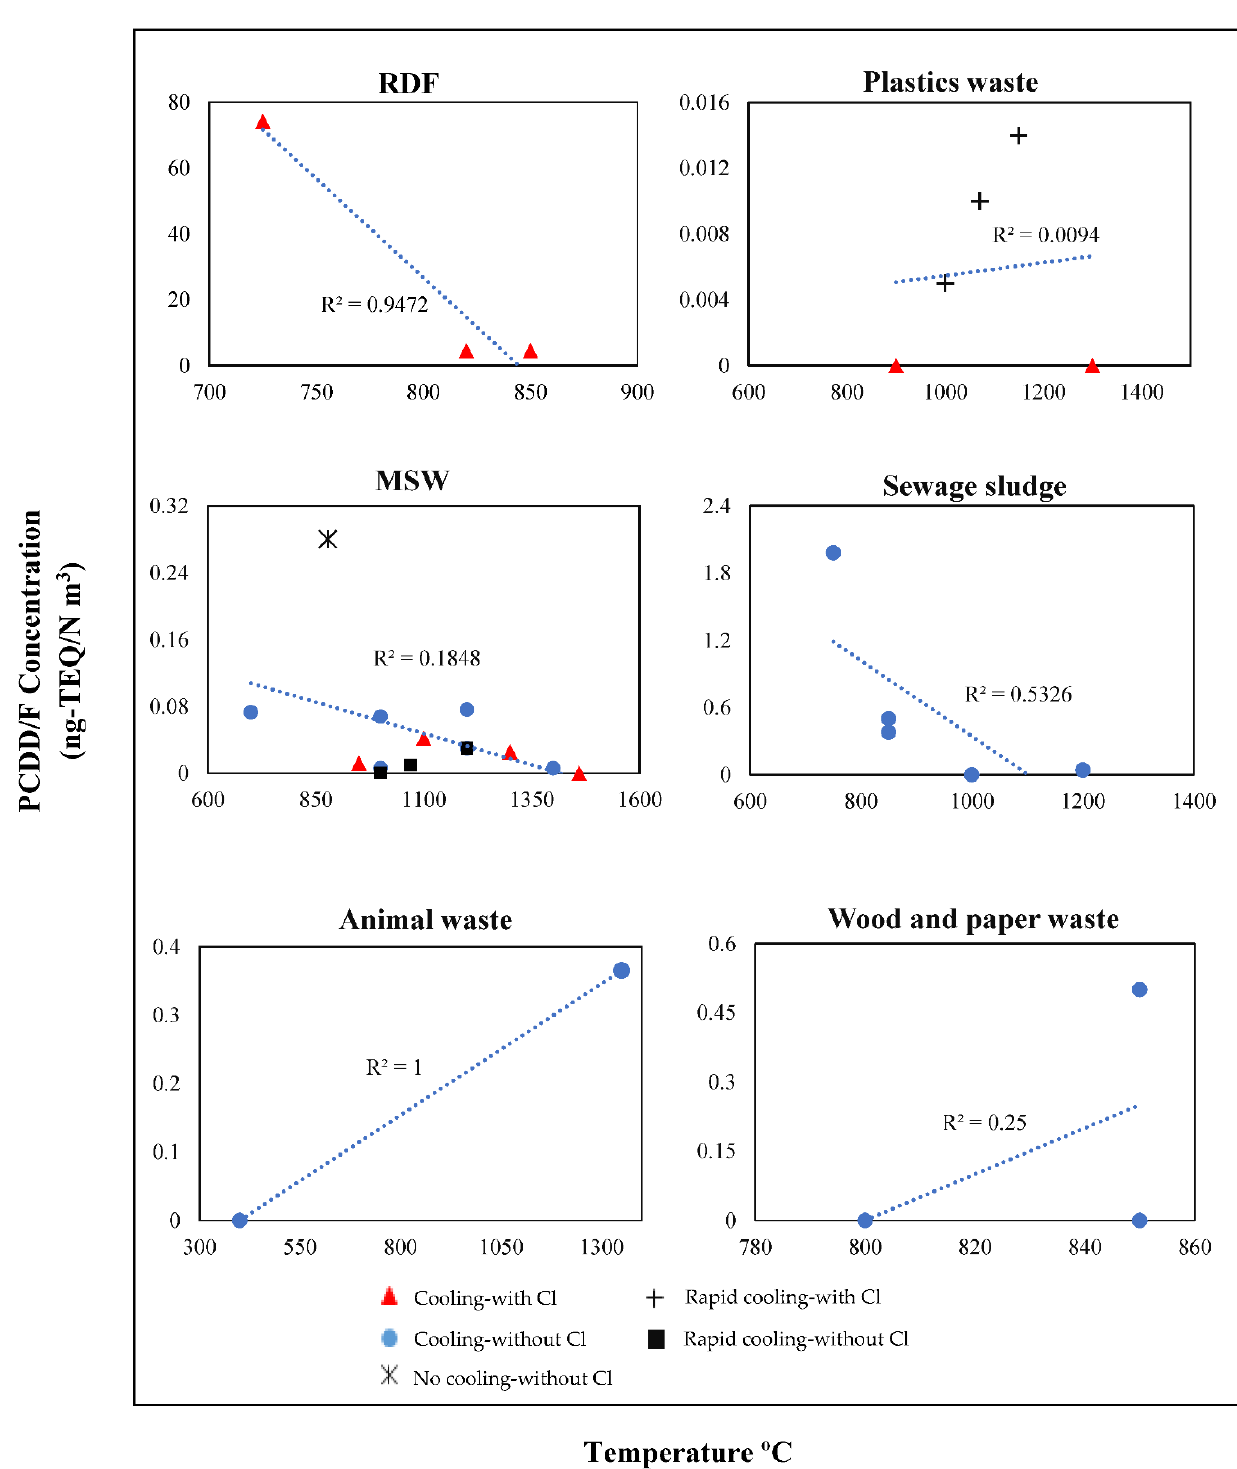
Figure 5. The scatter chart shows the PCDD/Fs concentrations for each feedstock versus temperature. Since there is only one study experimenting with textile and hospital waste, they are not included in this figure. The symbols show if any cooling methods/rapid cooling were used and whether high-chlorine-level feedstock were used.